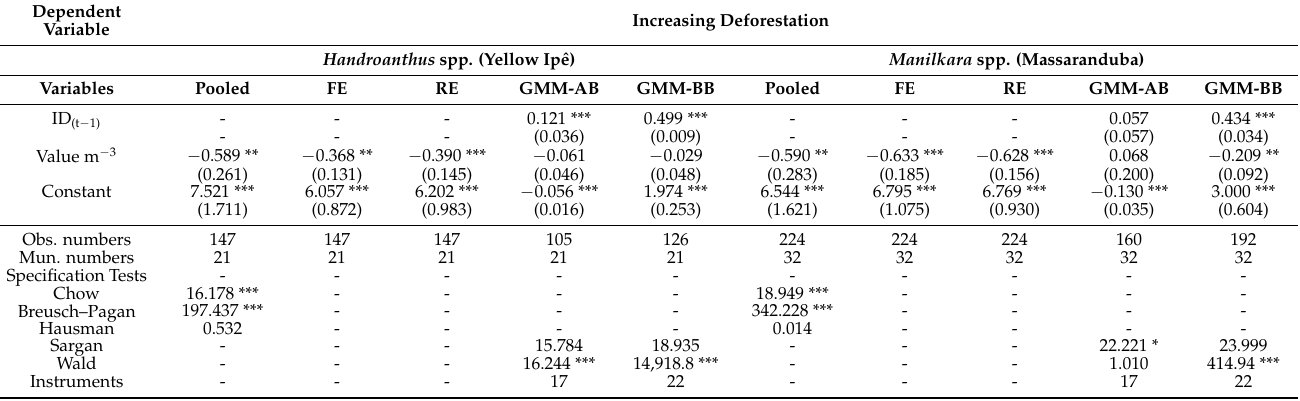
Table 5. Results of panel models of the increase in deforestation in relation to the value per m 3 for Handroanthus spp. and Manilkara spp. in the municipalities of Par á , from 2009 to 2015.